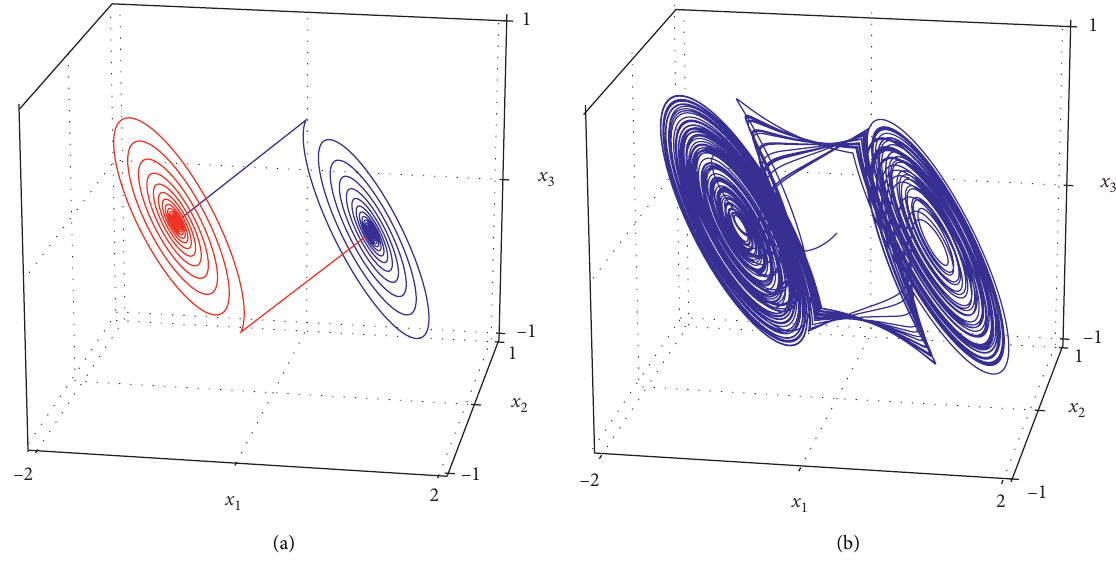
− x � 0 􏼈 􏼉 and the parameters 1 3